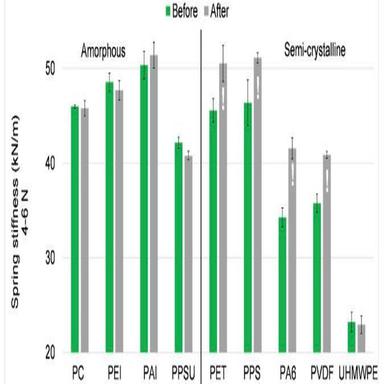
Spring stiffness of tested thermoplastics before and after wear.